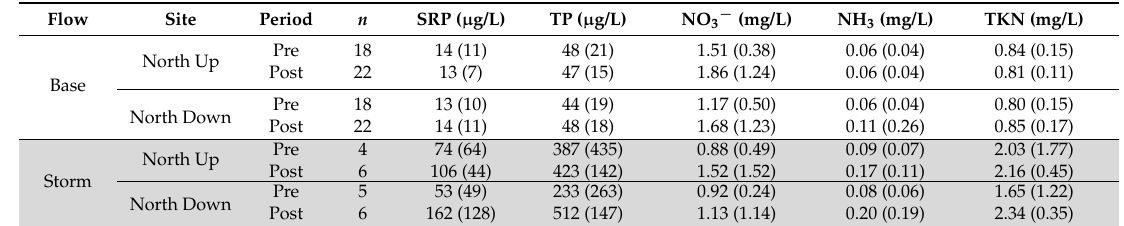
Table 10. Grand mean (1 SD) values of selected nutrient concentrations at the Haworth restoration site in pre- and postrestoration sampling periods. Values in the top half of each cell represent prerestoration (Apr. 2014–Sep. 2015); values in the bottom half represent postrestoration (Oct. 2015–Nov. 2017). Storm flow data shown in gray shade.